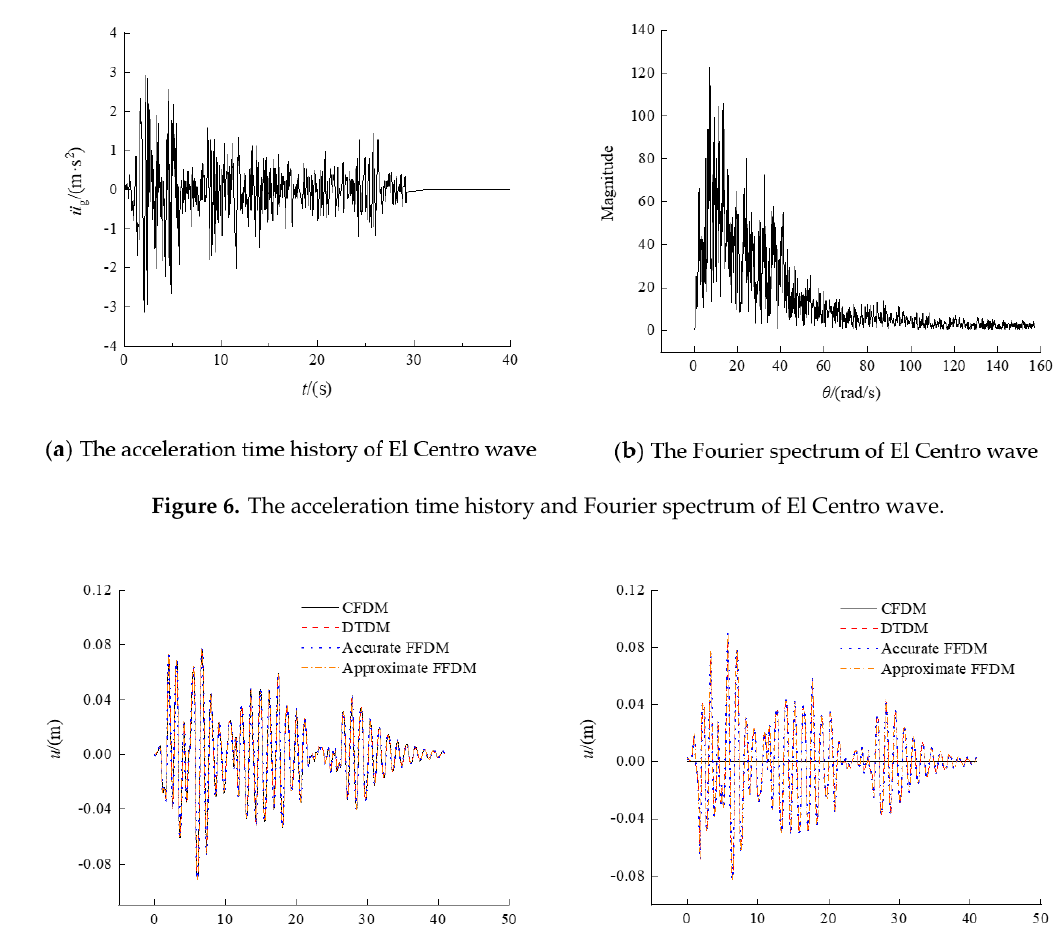
Figure 6. The acceleration time history and Fourier spectrum of El Centro wave.